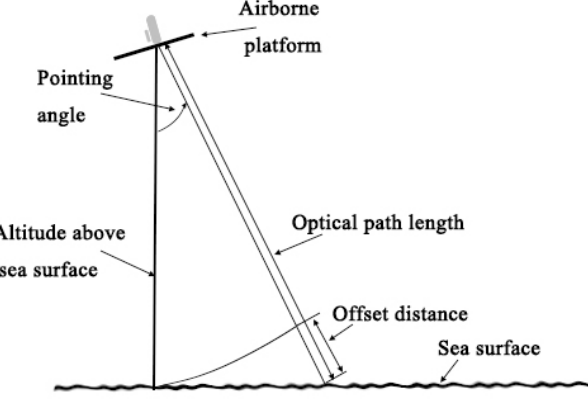
Figure 6. A geographic model of distance offset caused by pointing angles. The point angle represents the combined effect of the pitch and roll angles. The altitude above the sea level is the distance perpendicular to the sea level from the plane.